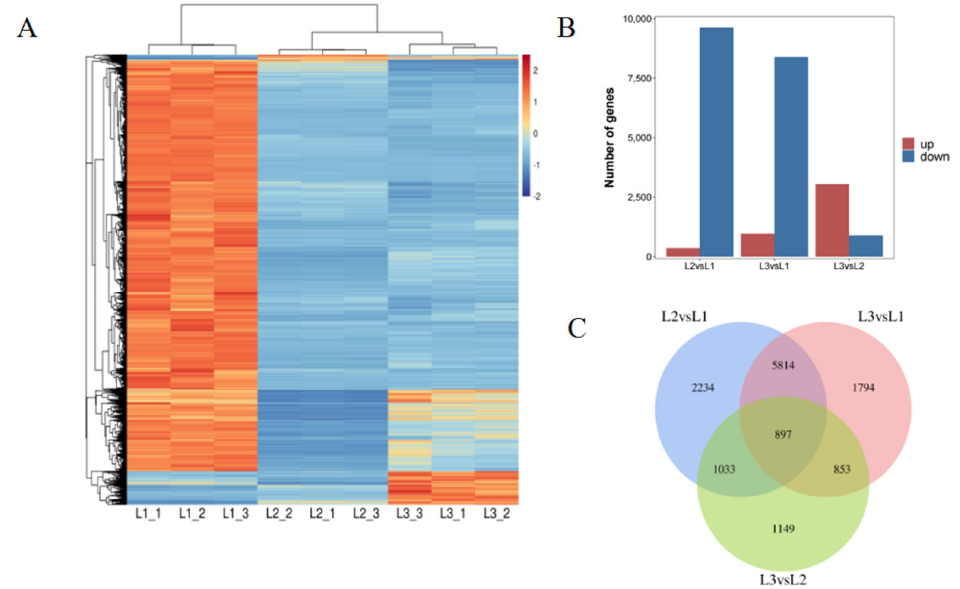
Figure 3. Characteristics and expression analysis of DEGs in walnut embryos at different developmental stages. ( A ) Heat map of DEGs based on FPKM. The color scale represents the calculated Z − score. Red and blue indicate higher and lower abundances, respectively. ( B ) Number of DEGs in the different combinations. The blue bar denotes downregulated genes; the red bar denotes upregulated genes. ( C ) Venn diagram of DEGs in the different combinations. L1 was 60, L2 was 90, and L3 was 120 DAP. (L2 − VS − L1, L3 − VS − L1, L3 − VS − L2; “a” was the experimental group; “b” was the